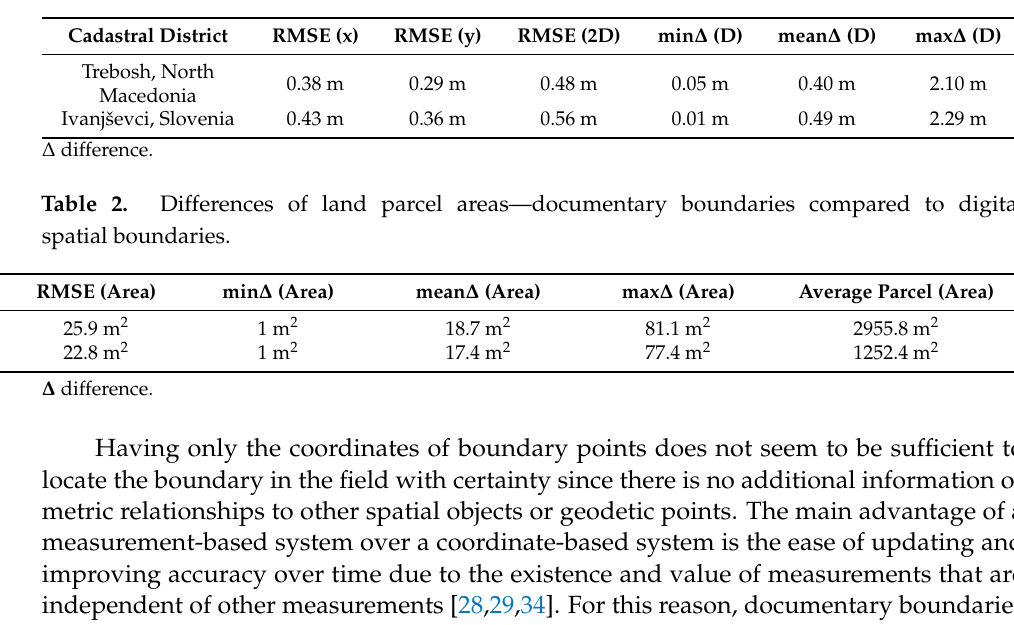
Table 1. Positional accuracy of boundary points—documentary boundaries compared to digital spatial boundaries.